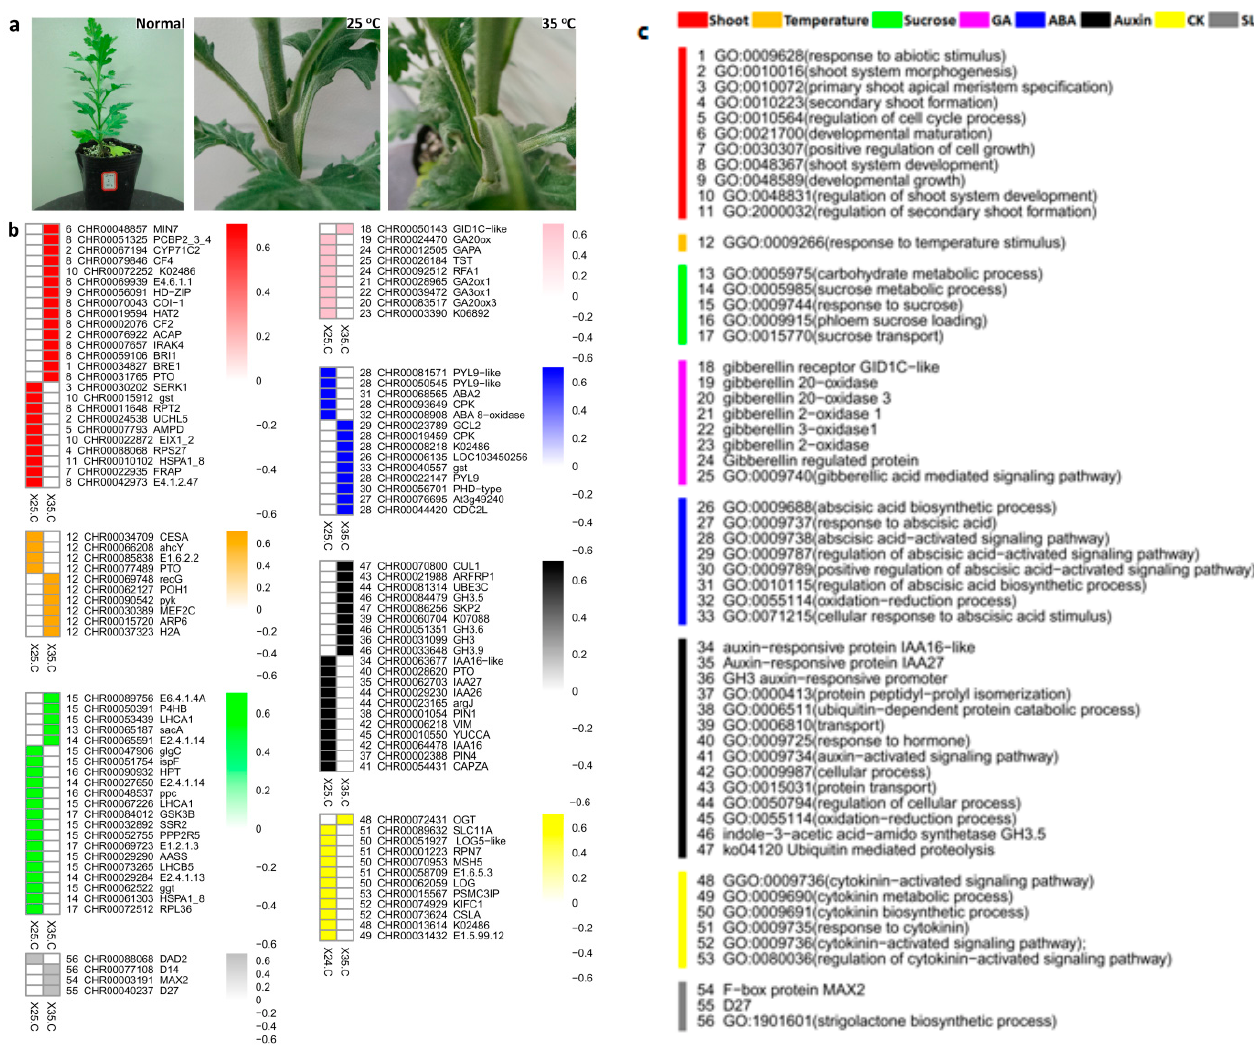
Figure 2. Bud outgrowth pattern and antagonistic expression of specific DEGs in non-decapitated plants. ( a ) Non-decapitated plants growing in 25 °C and 35 °C regimes. Top one shows the normal growth of plant before temperature treatment. The lower two plants show the effect of temperature on bud outgrowth. Bud outgrowth is suppressed in under the influence of 35 °C. This is the core idea to go for transcriptomic analysis and find some hormonal and genetic regulators of bud arrest due to increase in temperature; ( b ) Contrasting expression of DEGs expressed for pivotal regulators of bud formation and outgrowth; ( c ) explanation of colors and details of numbers as biological process annotations used in ʹ b ʹ .